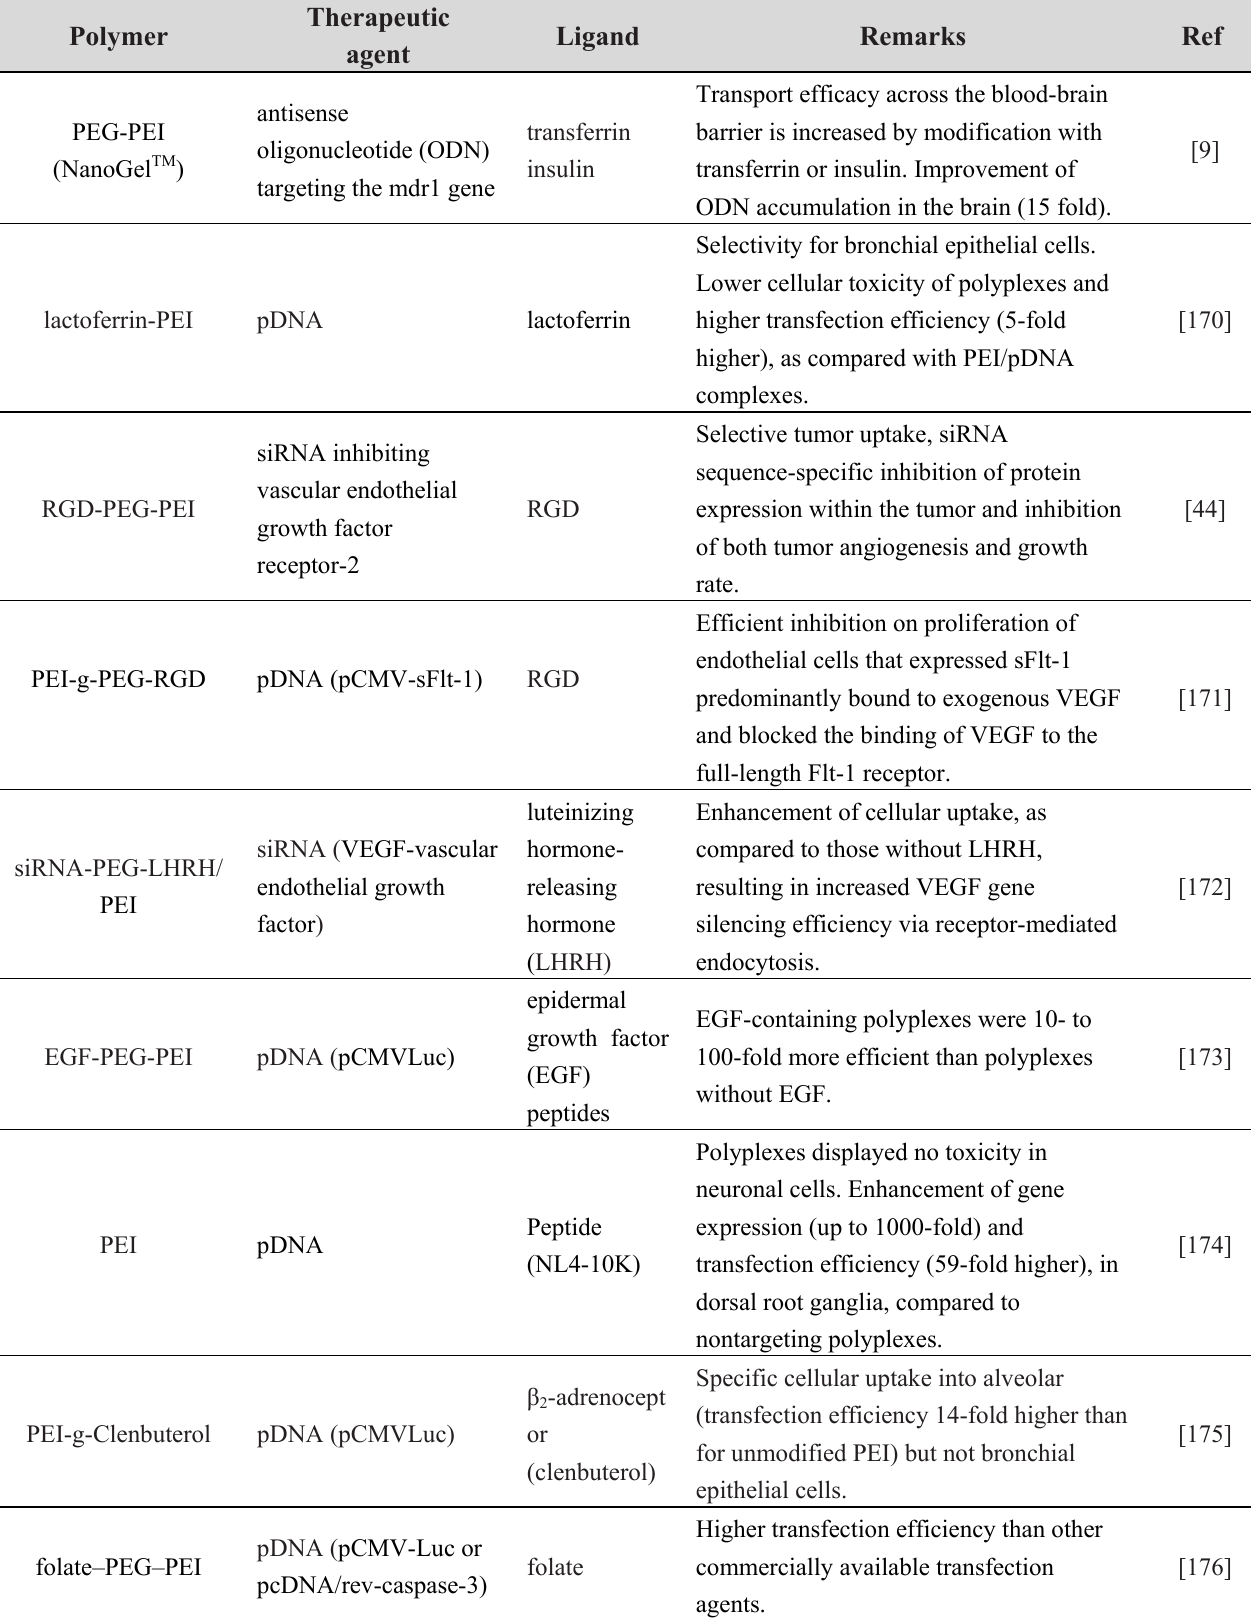
Table 4. Polyethylenimine (PEI) and poly(l-lysine) (PLL)-based polymers for gene